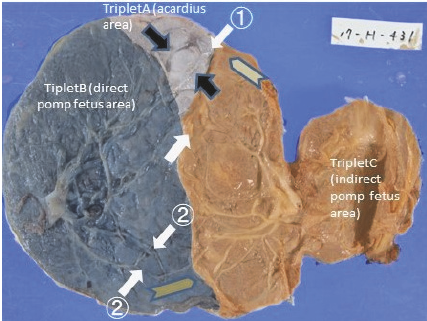
Figure 2: Photograph of the placental vascular surface. The black arrow indicates the anastomoses between the acardiac fetus and the direct pump fetus. The white arrow indicates the anastomoses between the direct pump fetus and the indirect pump fetus. A is the anastomoses between the umbilical artery of the direct pump fetus and the umbilical artery of the indirect pump fetus. B is the anastomosesbetweentheumbilicalveinofthedirectpumpfetusand the two umbilical veins of the indirect pump fetus. The gray arrow indicates the direction of blood flow in the vascular